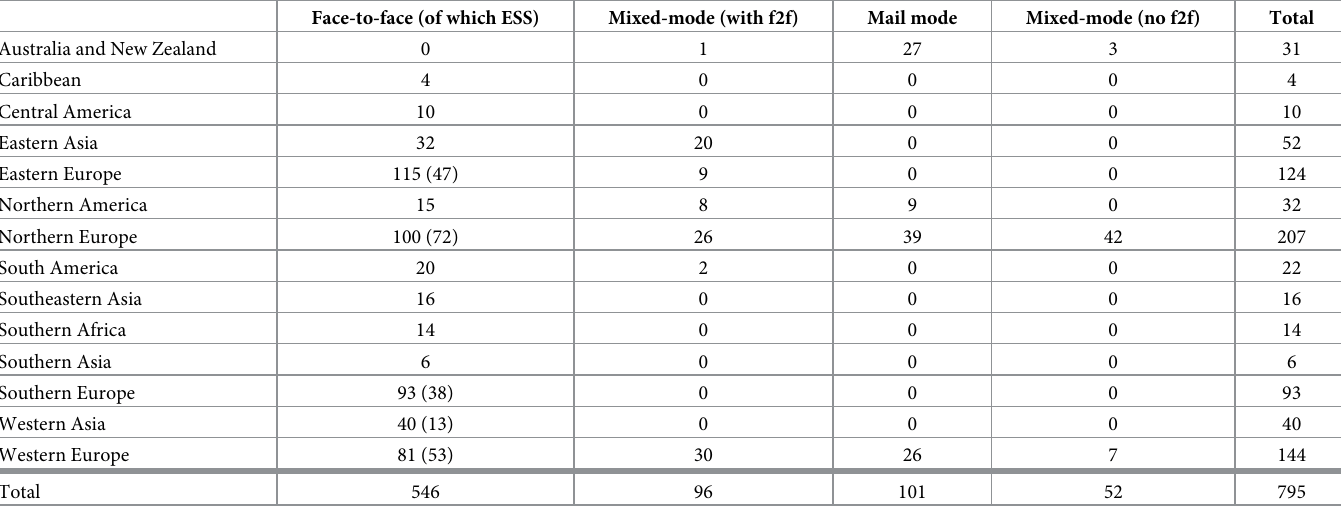
Table 1. Distribution of survey modes in analyzed dataset by the United Nations world